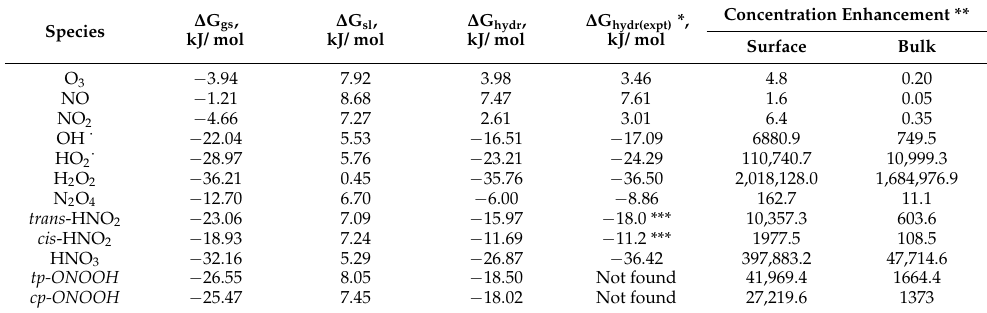
* These ∆ G hydr values are calculated from experimental Henry’s law constants from the Compilation of Henry’s law constants (version 4.0) by Sander [54] if not stated otherwise. ** Concentration enhancement represents the ratio of the concentration of species at the water surface and water bulk to that of the gaseous phase. *** Data from [43,55]. Based on the permeabilities of the water bulk, we divided the studied RONS into two groups: (i) hydrophilic species with ∆ G hydr < 0 (hydration free energy, which corresponds to the transport of a compound from the gaseous phase into the solvent, i.e., water in this case) and (ii) hydrophobic species with ∆ G hydr > 0. We try to discuss our results by following this grouping. The FEPs of the hydrophilic RONS, i.e., OH˙, HO 2 ˙, H 2 O 2 , trans -HNO 2 , cis -HNO 2 , HNO 3 , tp-ONOOH , cp-ONOOH and N 2 O 4 , follow the general trend by decreasing at the water interface where FEPs have minimum values. Moreover, according to the FEPs, a shift in the free energy minimum from the water surface towards the water bulk phase (cf. Figures 2–4 below) can be observed. They show different hydration free energies depending on their chemical composition and